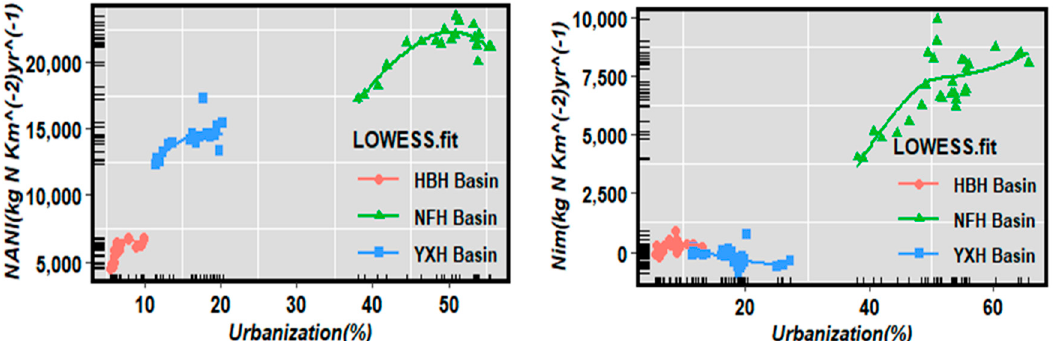
Figure 7. The relationship between urbanization and the NANI, N im in different types of water-